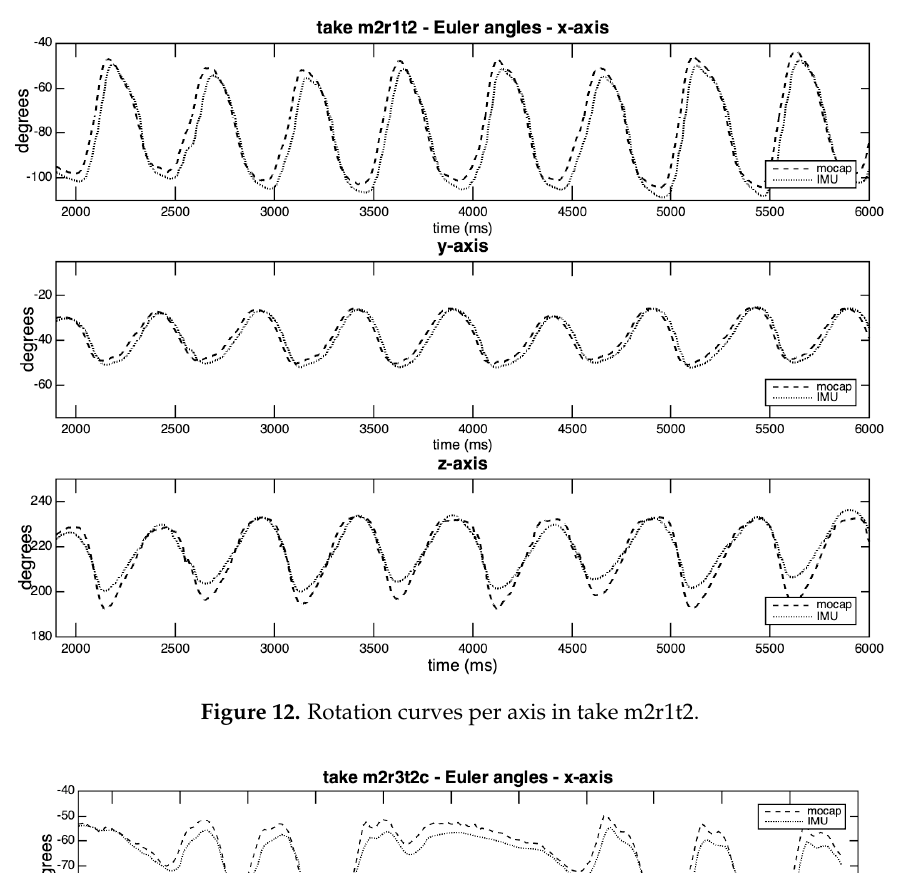
Figure 12. Rotation curves per axis in take m2r1t2.